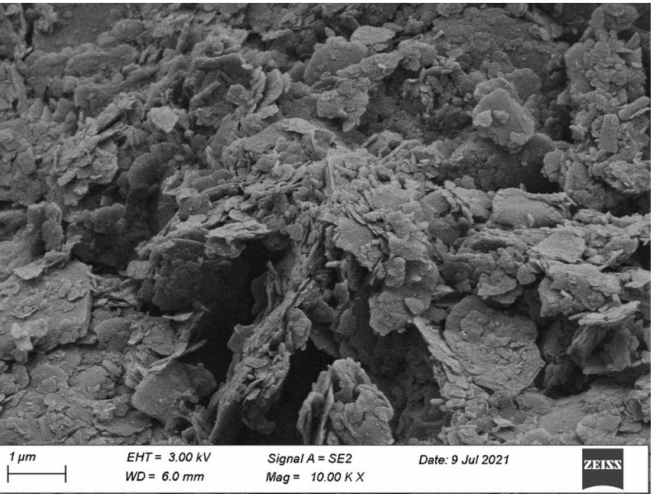
Figure 3. The microstructure of dredged